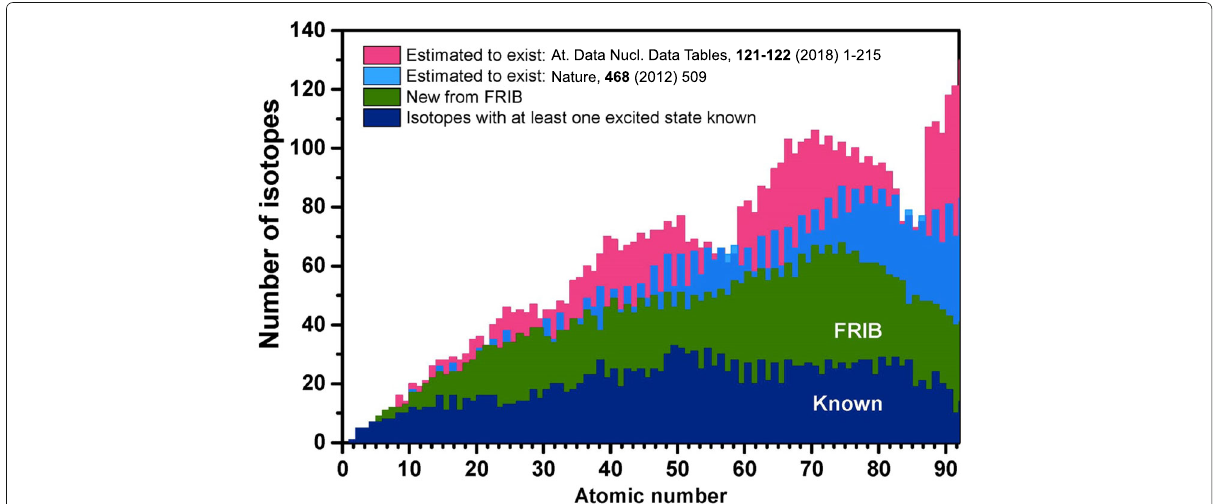
Fig. 3 (Color online) Number of isotopes of elements up to uranium estimated to exist in theoretical predictions and to be produced at the Facility for Rare Isotope Beams (FRIB) in comparison with the known ones